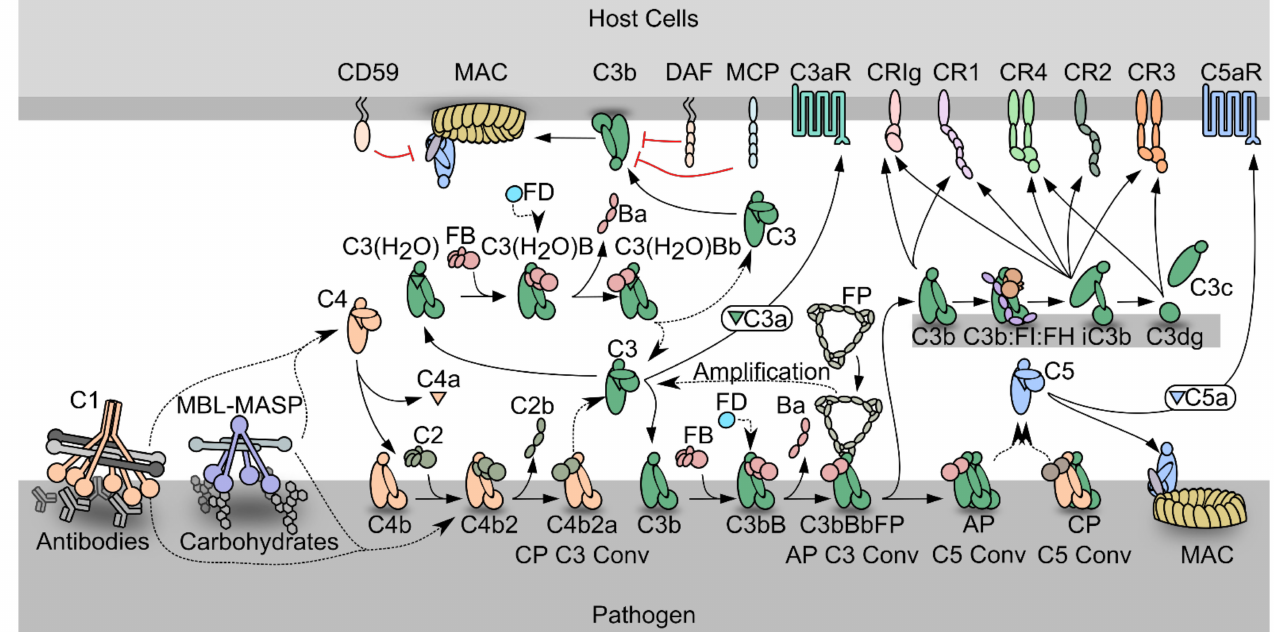
Figure 1. Schematic representation of the complement system. PRM-associated proteases activate upon binding of the PRMs to specific activators. The active proteases cleave C4, which undergoes a conformational change and covalently binds the activator. The zymogen C2 binds the opsonizing C4b, forming the C3 proconvertase. The active C3 convertase cleaves C3, which liberates the C3a fragment from C3b that covalently attaches to the activator. Factor B (FB) may bind the C3b, and upon activation by Factor D, the AP C3 convertase appears, that is stabilized by properdin (FP). C3 may also undergo spontaneous hydrolysis forming C3(H2O), which is a functional homologue of C3b and allows the assembly of a fluid phase C3 convertase. When the C3b concentration reaches a threshold density on the activator, the C3 convertases shifts specificity to C5. The resulting C5 convertases cleave C5 and the C5b forms the starting point for assembly of the membrane attack complex that may perforate the cell membrane. C3b may also undergo degradation by factor I assisted by cofactors. The degradation of C3b opens for interactions with complement